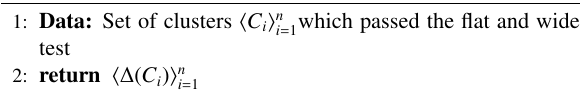
Algorithm 1 Treat flat and wide clusters